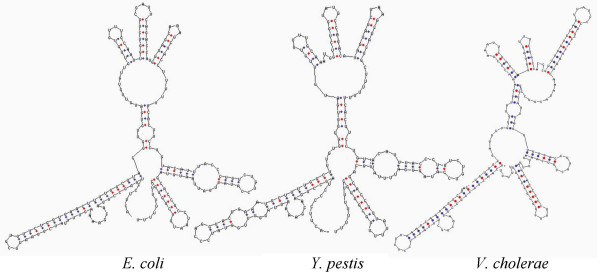
Secondary structures of GcvB RNAs with 77% (Y. pestis) and 53% (V. cholerae) identity to the E. coli GcvB RNA as predicted by the mfold algorithm [15].